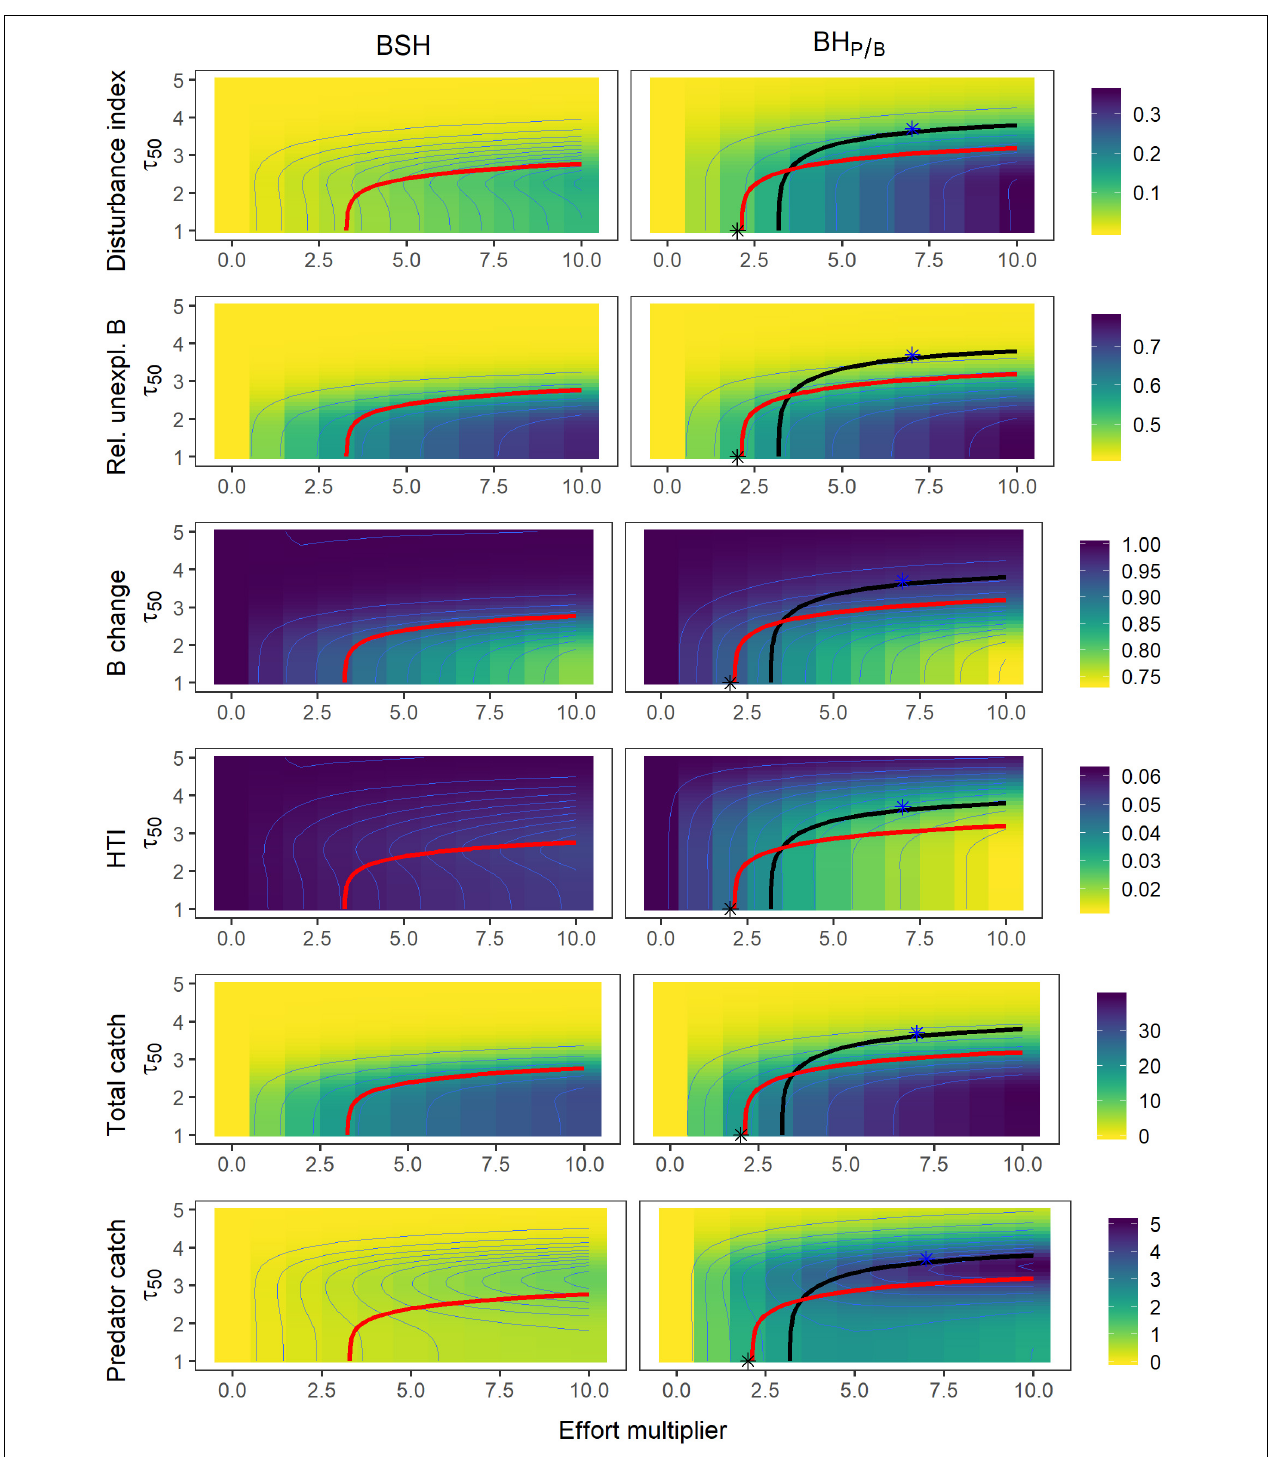
FIGURE 6 | Contour plots of the different performance measures as a function of the harvest intensity (effort multiplier) and the trophic level at first capture ( τ 50 ), under a BSH fishing pattern ( left panels) and BH P / B ( right panels). Thick isolines depict combinations of τ 50 values and effort multipliers that lead to (A) a 40% decrease in predator biomass (black), and (B) a catch of 80% maximum catch (red). The stars (*) depict fishing patterns and strategies that maximize total catch (black) and predator catch (blue), while not depleting biomass below 60% virgin biomass.